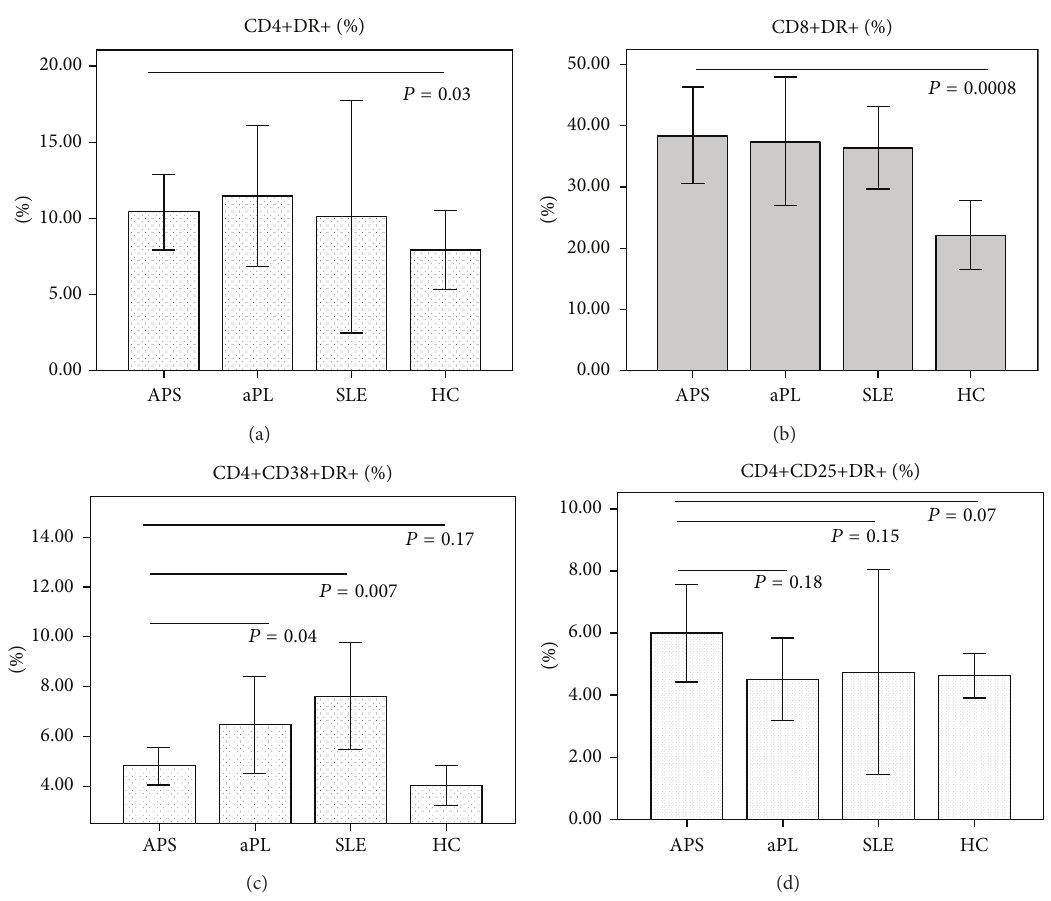
Figure 1: Activated lymphocyte subsets. CD4+ and CD8+ activated T-cell subsets in APS patients and controls. APS: thrombotic APS; aPL: aPL positive controls without APS clinical criteria; HC: healthy controls; SLE: systemic lupus erythematosus controls. Subsets are expressed as percentages over total CD4+ or CD8+